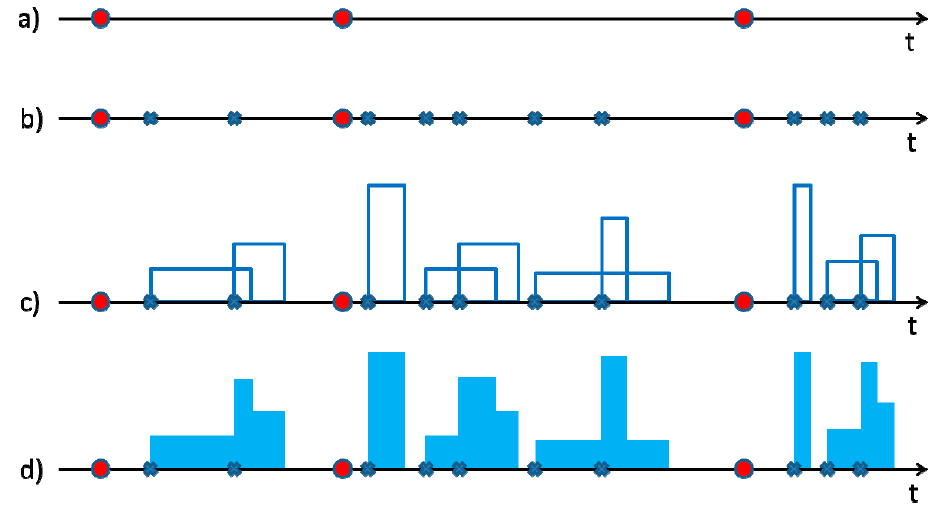
Figure 1. Representation of the Neyman–Scott Rectangular Pulses (NSRP) stochastic process for at-site rainfall modeling: ( a ) occurrences of storms (Equation (1)); ( b ) for each storm, determination of the number of pulses (Equation (2)) and their temporal occurrences (Equation (3)); ( c ) estimation of intensity and duration for all the pulses (Equations (4) and (5)); ( d ) calculus of total intensity at time t (Equation